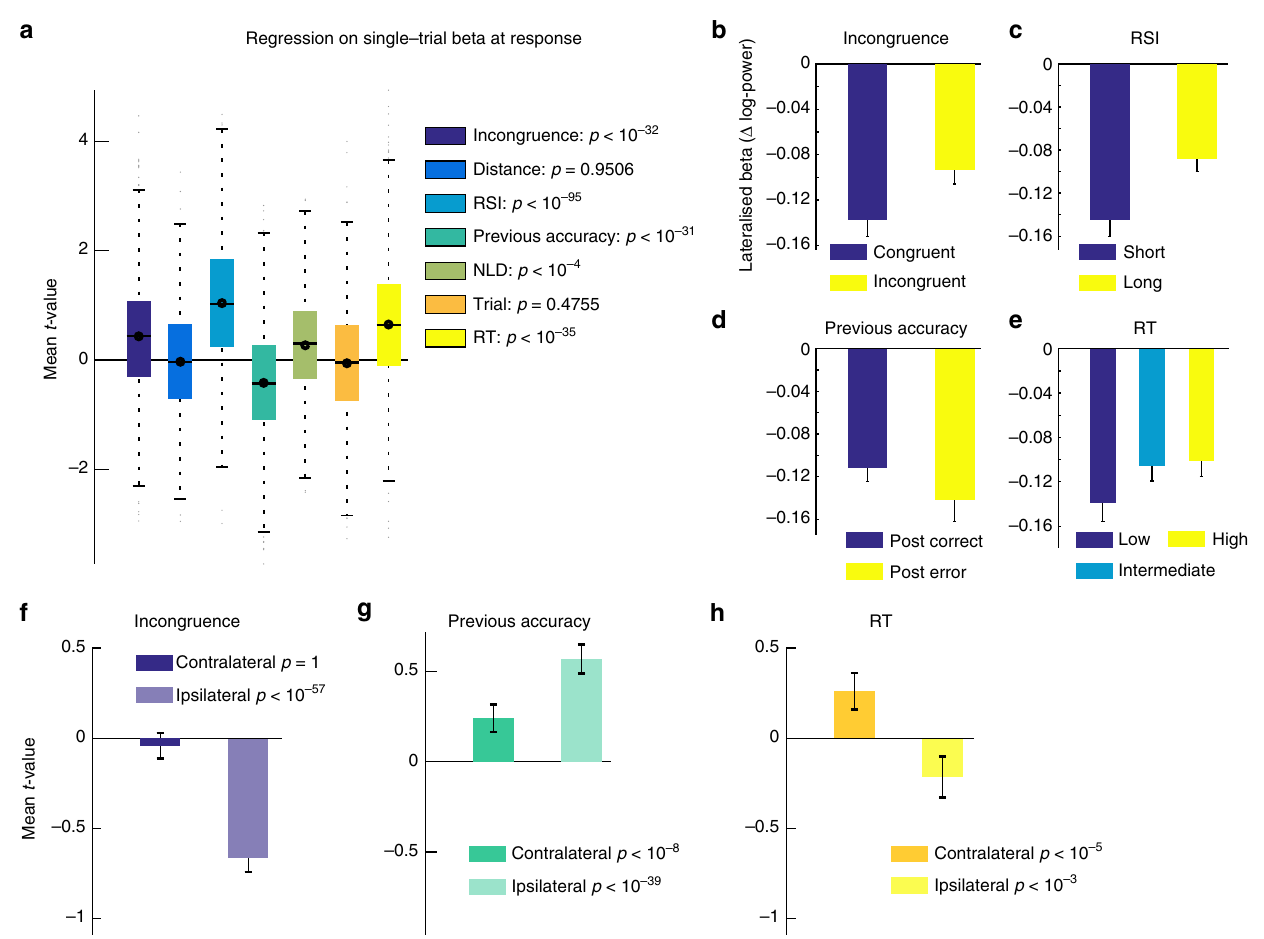
Fig. 7 Single-trial regression on beta at response. a Results of a single-trial regression analysis on BPL at response (mean ± 12 ms surrounding button press), comparing relevant task factors. This analysis was performed to rule out that the results demonstrated for RT and post-error effects result from averaging over trials. b – d Re fl ect raw values splits for Incongruence (congruent vs incongruent), RSI (short vs fast) and Previous Accuracy (correct vs